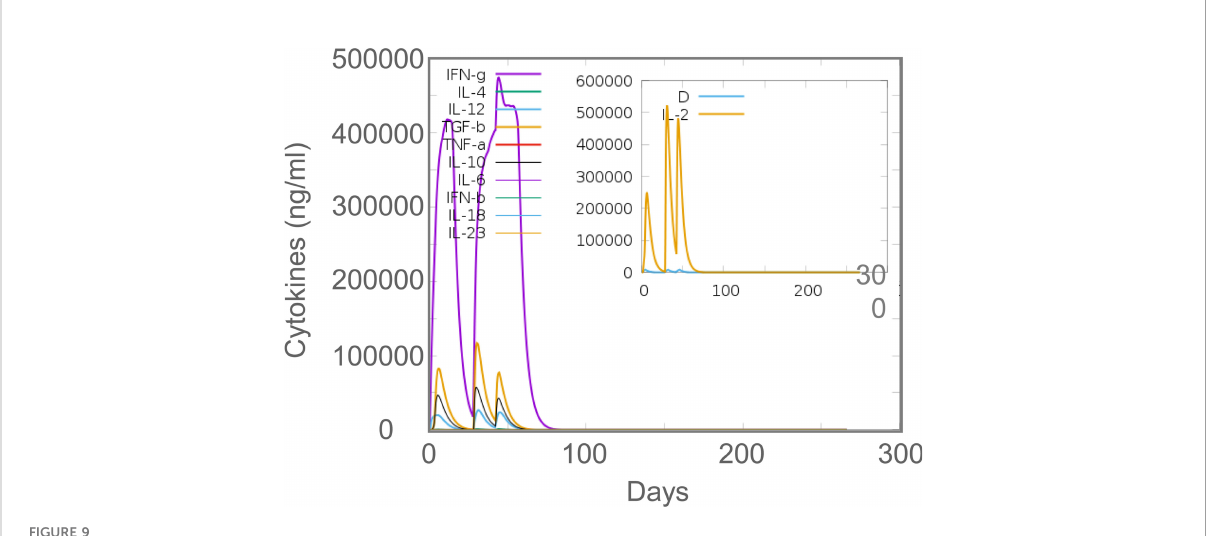
FIGURE 9 The levels of cytokines predicted by the C-ImmSim server.